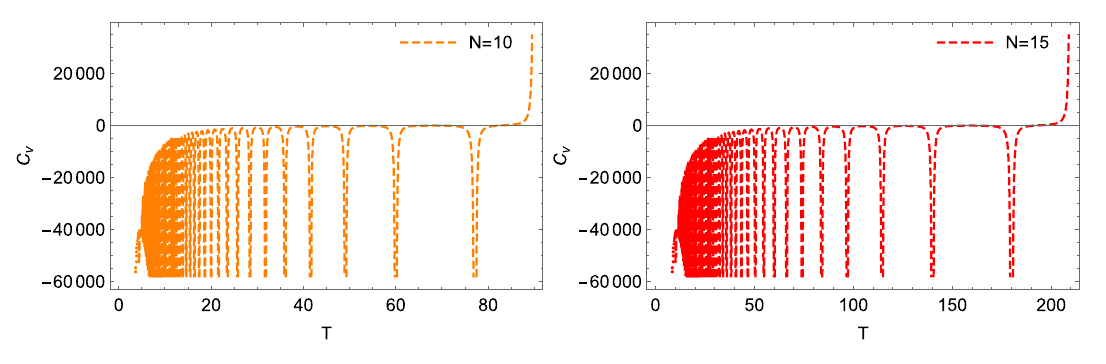
Fig. 3 Specific heat in terms of temperature with G = m = k = 1, and λ = 1 /